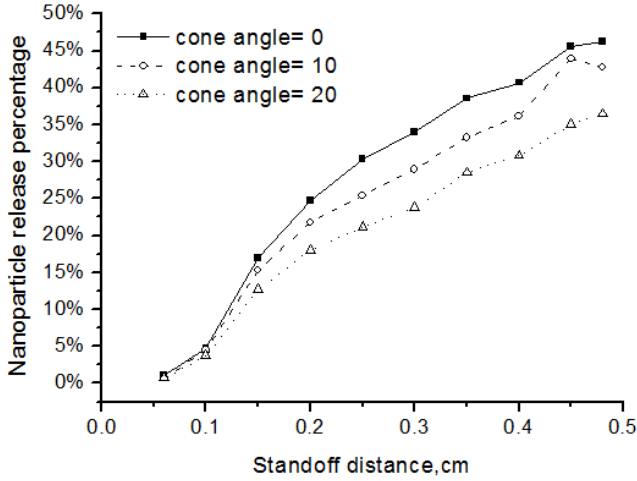
Figure 9. Effects of injection angle on the nanoparticle release percentage.